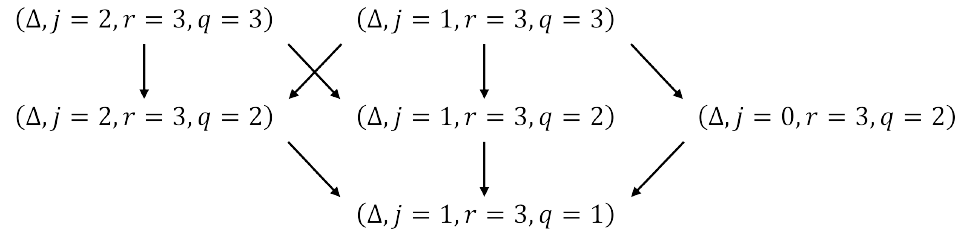
Figure 9: The second part of the rank-3 tensor representation of CCA consists of a { ∆ , r = 3 } representation.